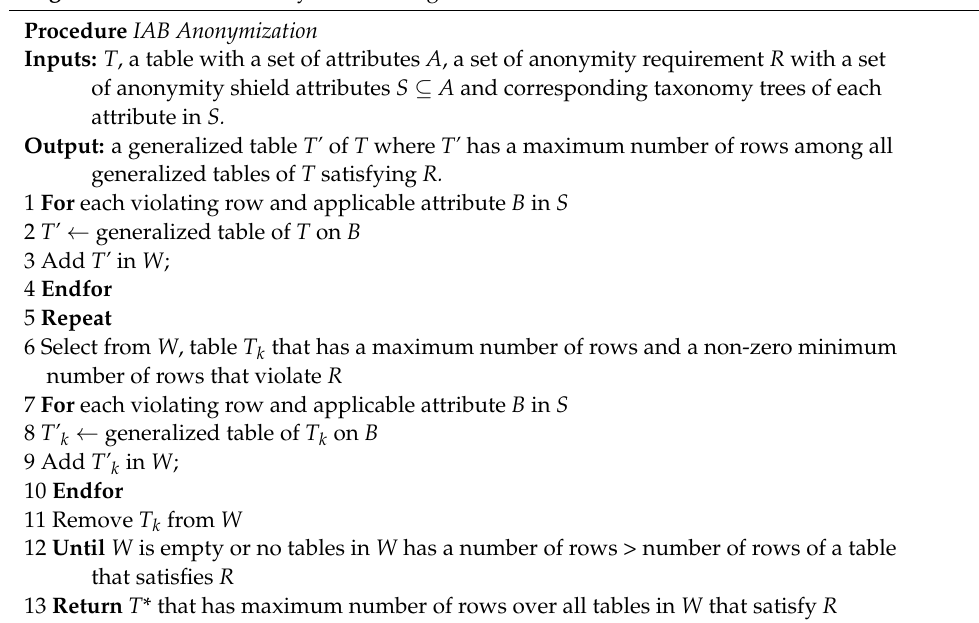
Algorithm 1 The IAB Anonymization Algorithm Procedure IAB